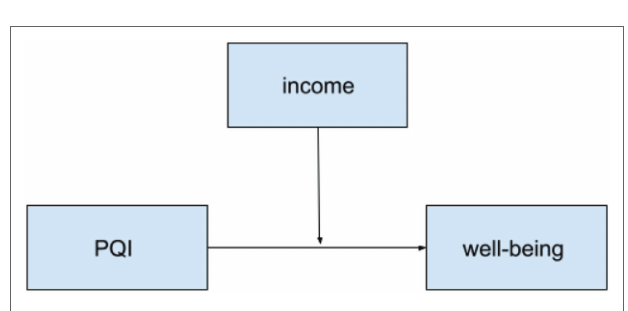
FIGURE 2 | Hypothesized two-way moderation model between PQI and income on well-being for both